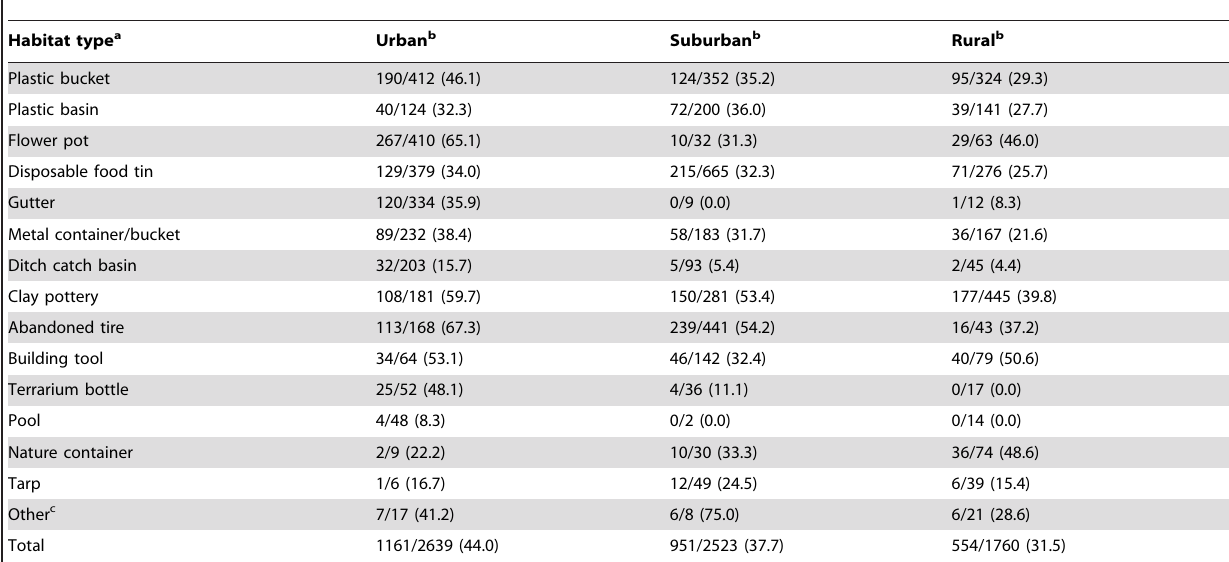
Table 1. Summary of Aedes albopictus in different study areas and habitat